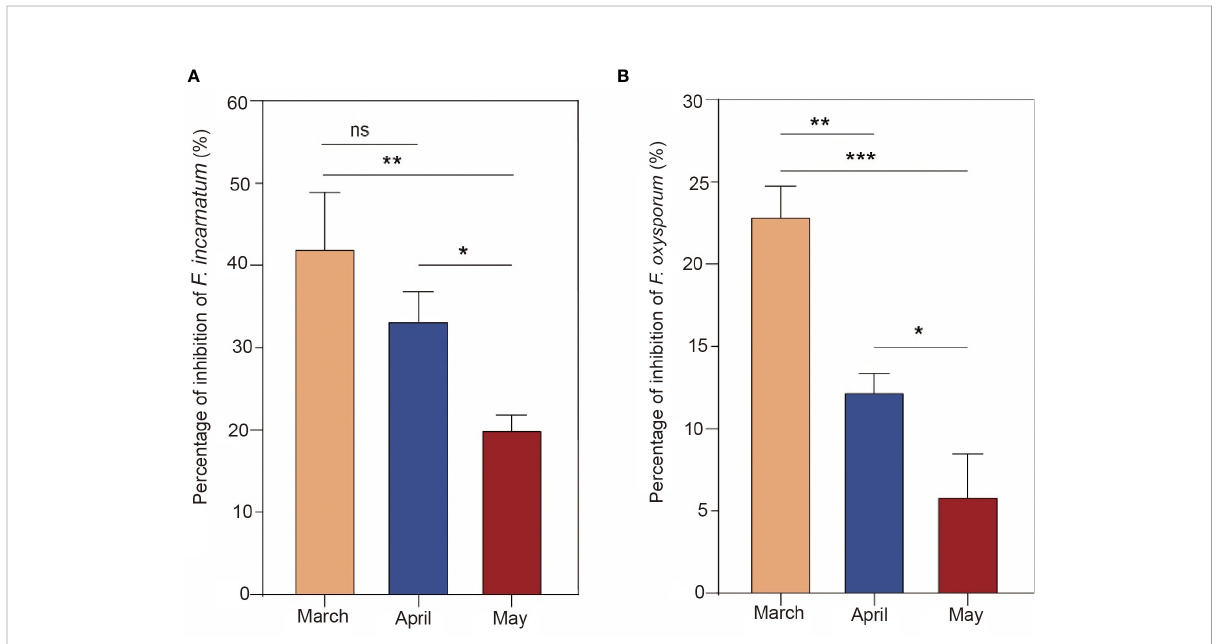
FIGURE 4 Antifungal activity of essential oils from different harvest periods (March, April, and May). The percent inhibition (means ± SDs) of Fusarium oxysporum (A) and Fusarium incarnatum (B) . The signi fi cance symbol “ * ” indicates a signi fi cant difference (*, P < 0.05; **, P < 0.01; ***, P < 0.001). The symbol "ns" indicates there was no signi fi cant difference (P>